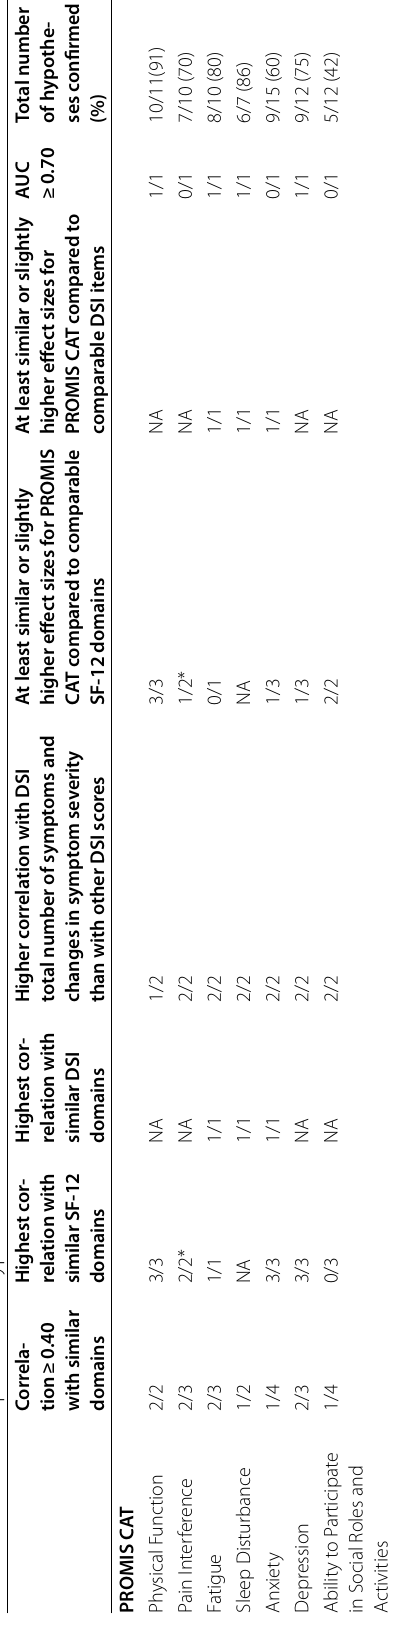
Table 4 Area under the ROC curve (AUC), representing the ability of PROMIS CATs to distinguish patients who deteriorated from patients who did not deteriorate, and minimal important change (MIC), representing a minimal important deterioration AUC MIC (95%CI) Physical Function Fatigue